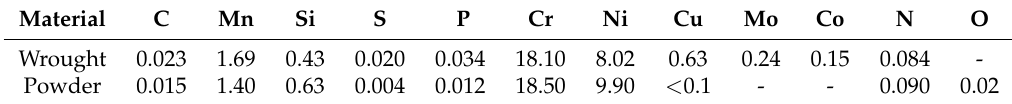
Table 1. Chemical properties (wt%) of 304L stainless steel powder and bulk 304 stainless steel. Material